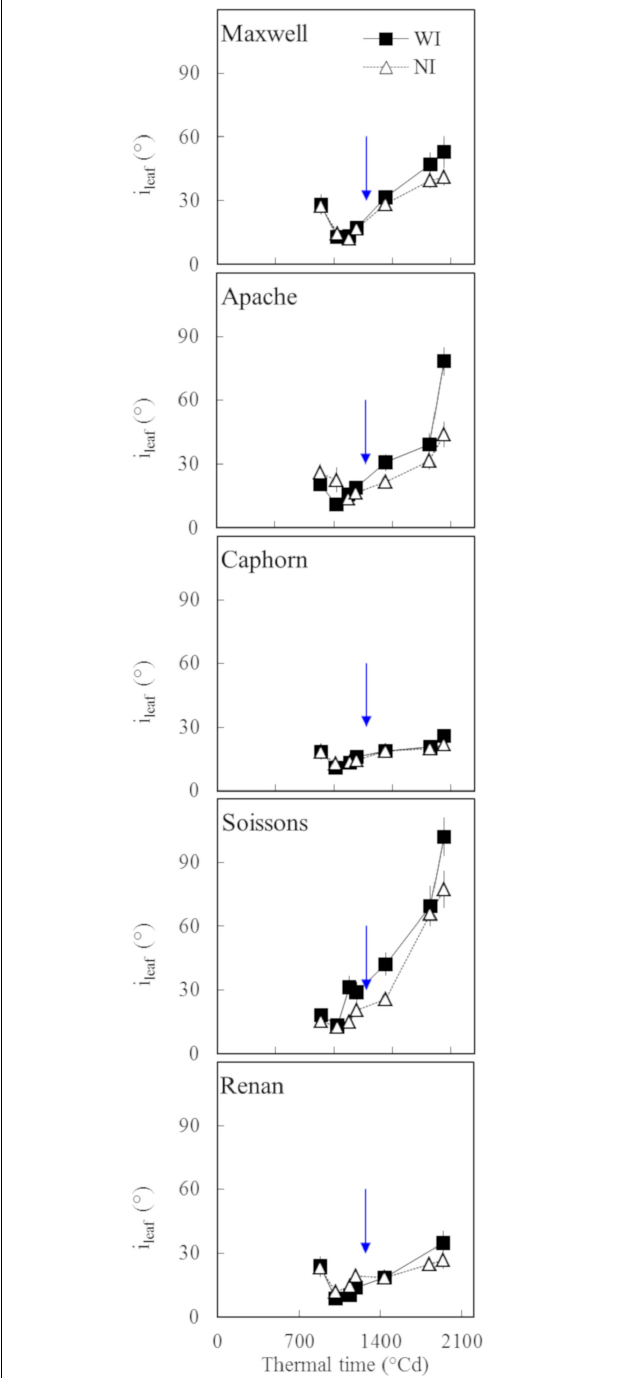
FIGURE 7 | The insertion angle ( i leaf ) averaged over the four upper leaves of the main stem vs. the thermal time from plant emergence. Each symbol represents the mean of values measured on 30 plants. Squares and solid lines represent the WI treatment, while triangles and dotted lines represent the NI treatment. Only leaf blades, having at least 20% green area, were taken into account. Error bars mark 95% confidence intervals of the mean estimates. The arrow indicates the second date of digitalization (1272 ◦ Cd), which is close to ear emergence